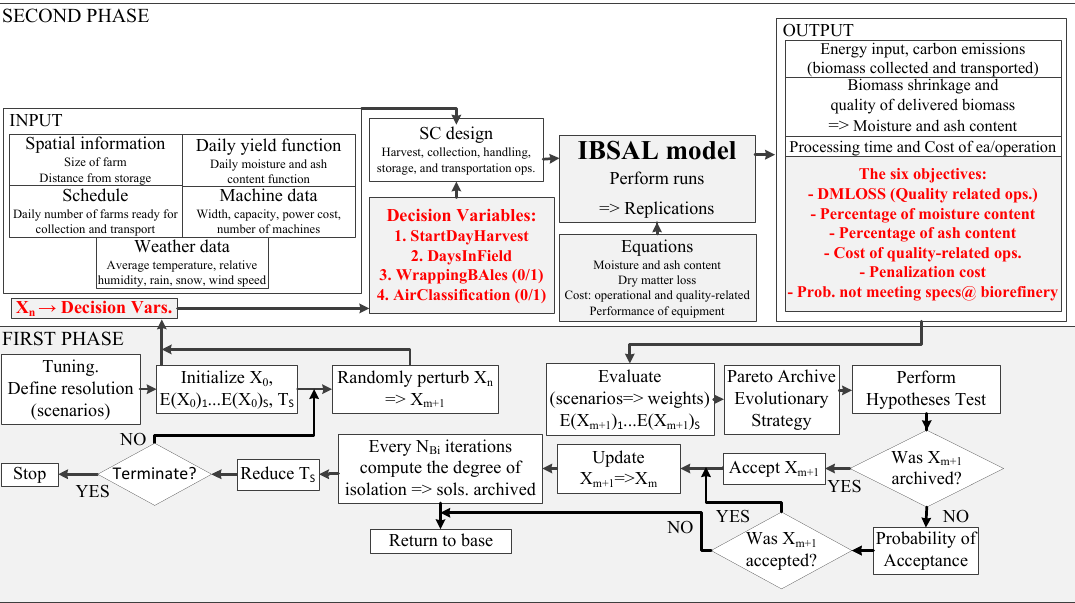
Figure 1. Extended IBSAL-SimMOpt method.